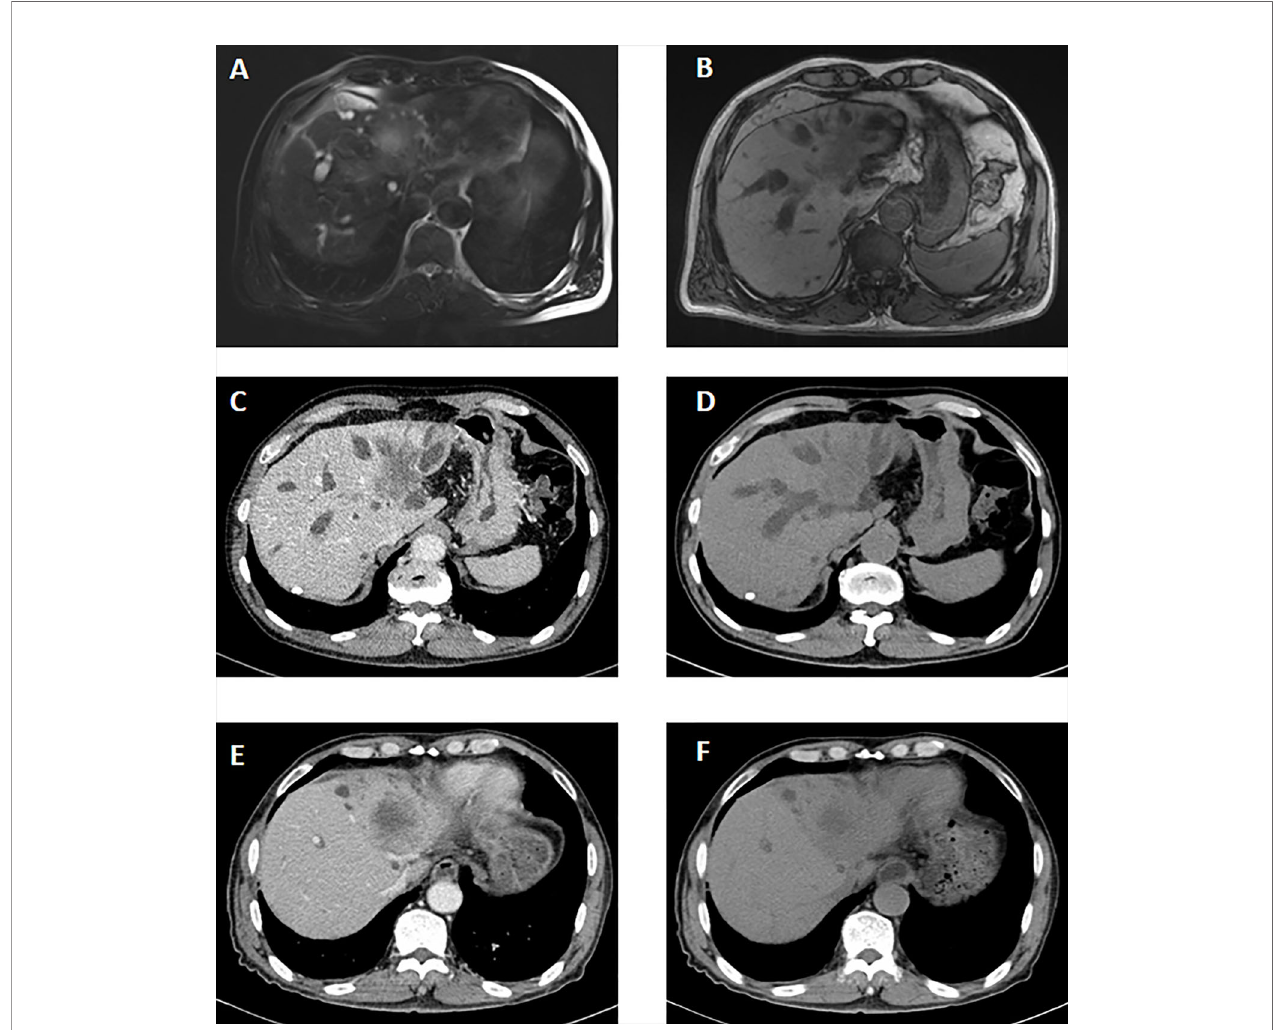
FIGURE 1 | The imaging manifestations of ASC in liver. The MRI features before the therapy. (A, B) It showed a long T2 signal mass with heterogeneous enhancement in arterial phase and delayed enhancement in portal phase in the hilar and left lobe of liver. A slightly long T1 signal mass with an unclear boundary was seen. The CT features before the therapy. (C, D) A slightly low-density mass was seen in the hilum and left lobe of liver, about 6.1*3.9 cm. On contrast- enhanced scan, the lesions were slightly inhomogeneous and mainly marginal. The CT features after percutaneous transhepatic cholangial drainage (PTCD) and targeted therapy. (E, F) Low density mass shadow was seen in the hilus hepatis and left lobe of liver with unclear boundary. The enhancement degree of lesions after enhanced scanning was lower than that before